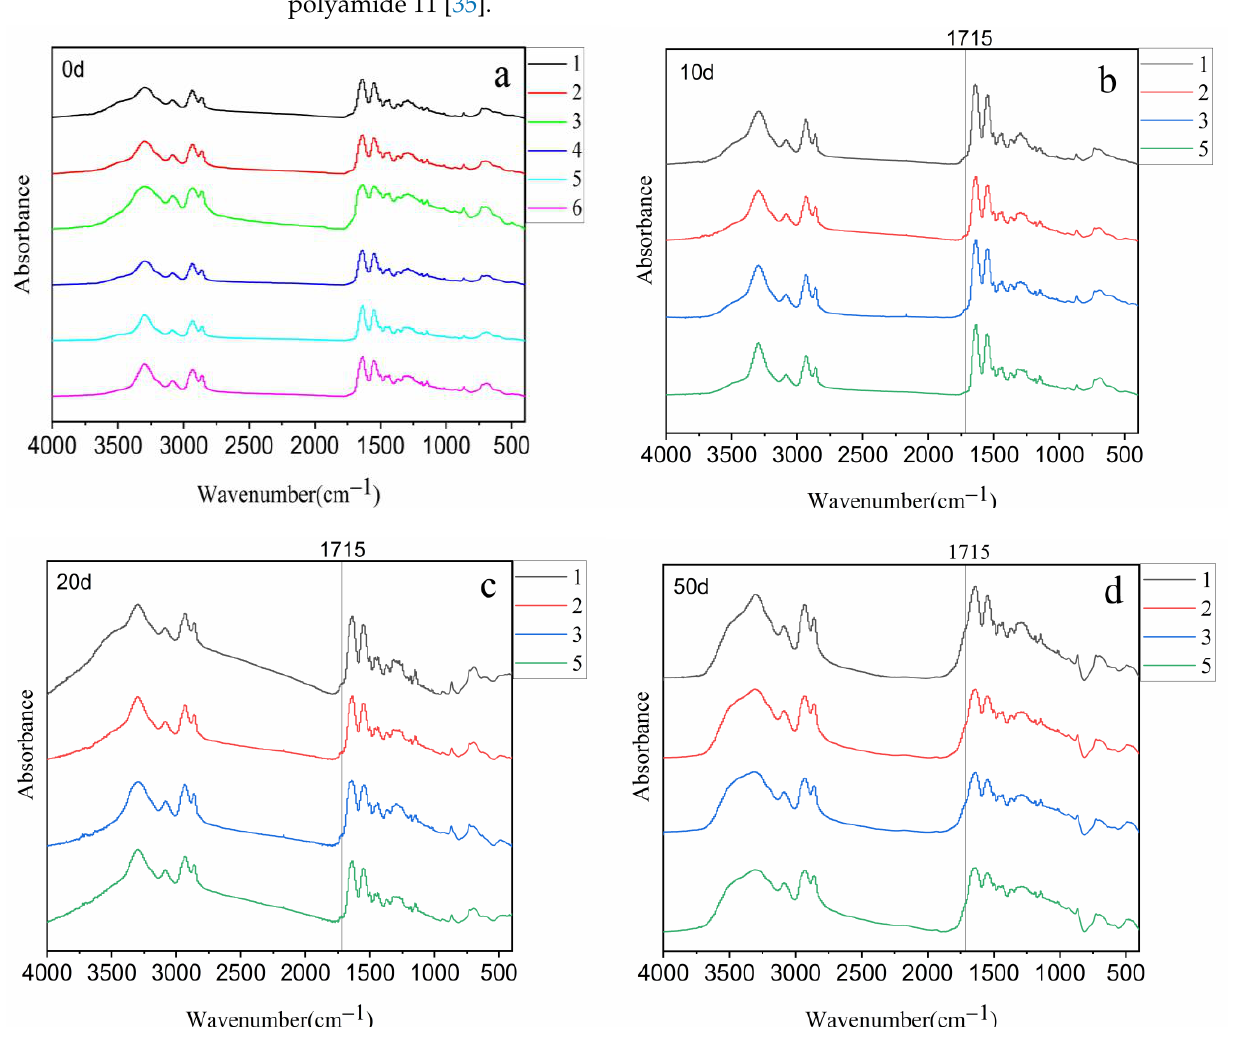
Figure 4. The infrared spectrum of samples: ( a ) sample before aging; ( b ) samples 1, 2, 3, and 5 after aging for 10 days; ( c ) samples of 1, 2, 3, and 5 after aging for 20 days; ( d ) samples 1, 2, 3, and 5 after aging for 50 days.